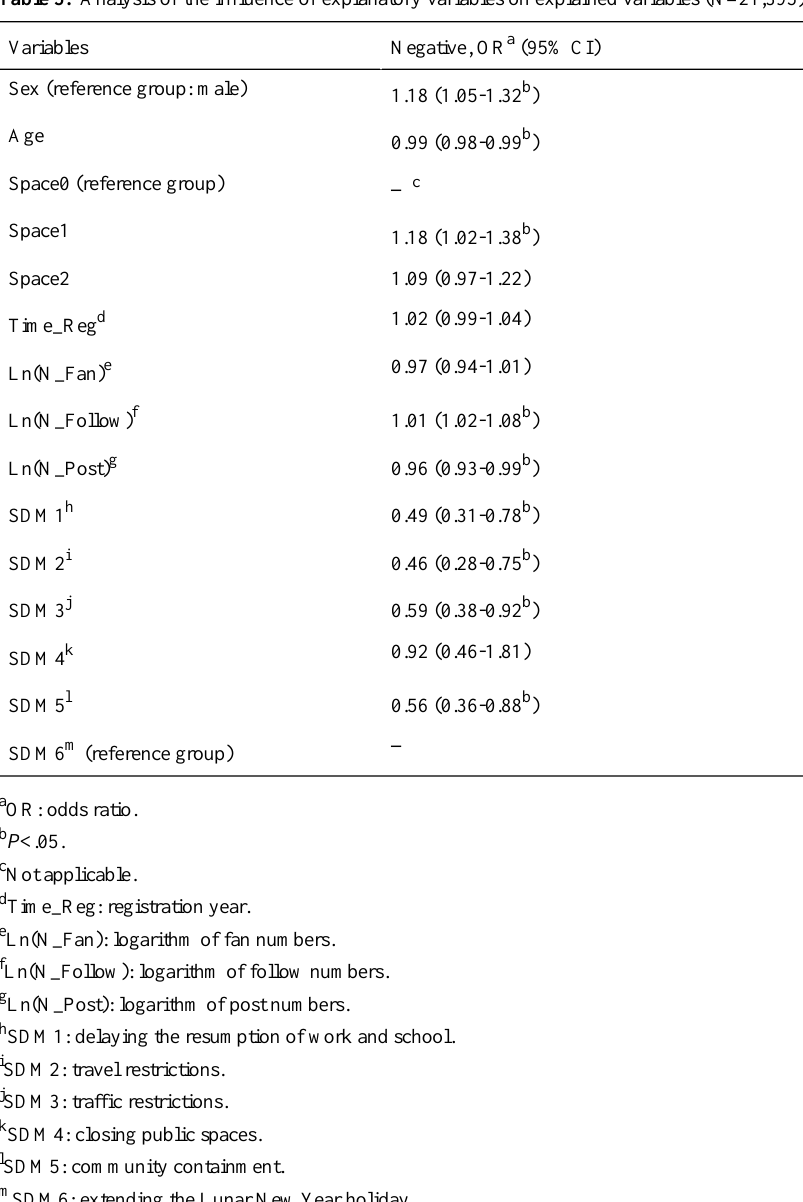
Table 5. Analysis of the influence of explanatory variables on explained variables (N=21,395).